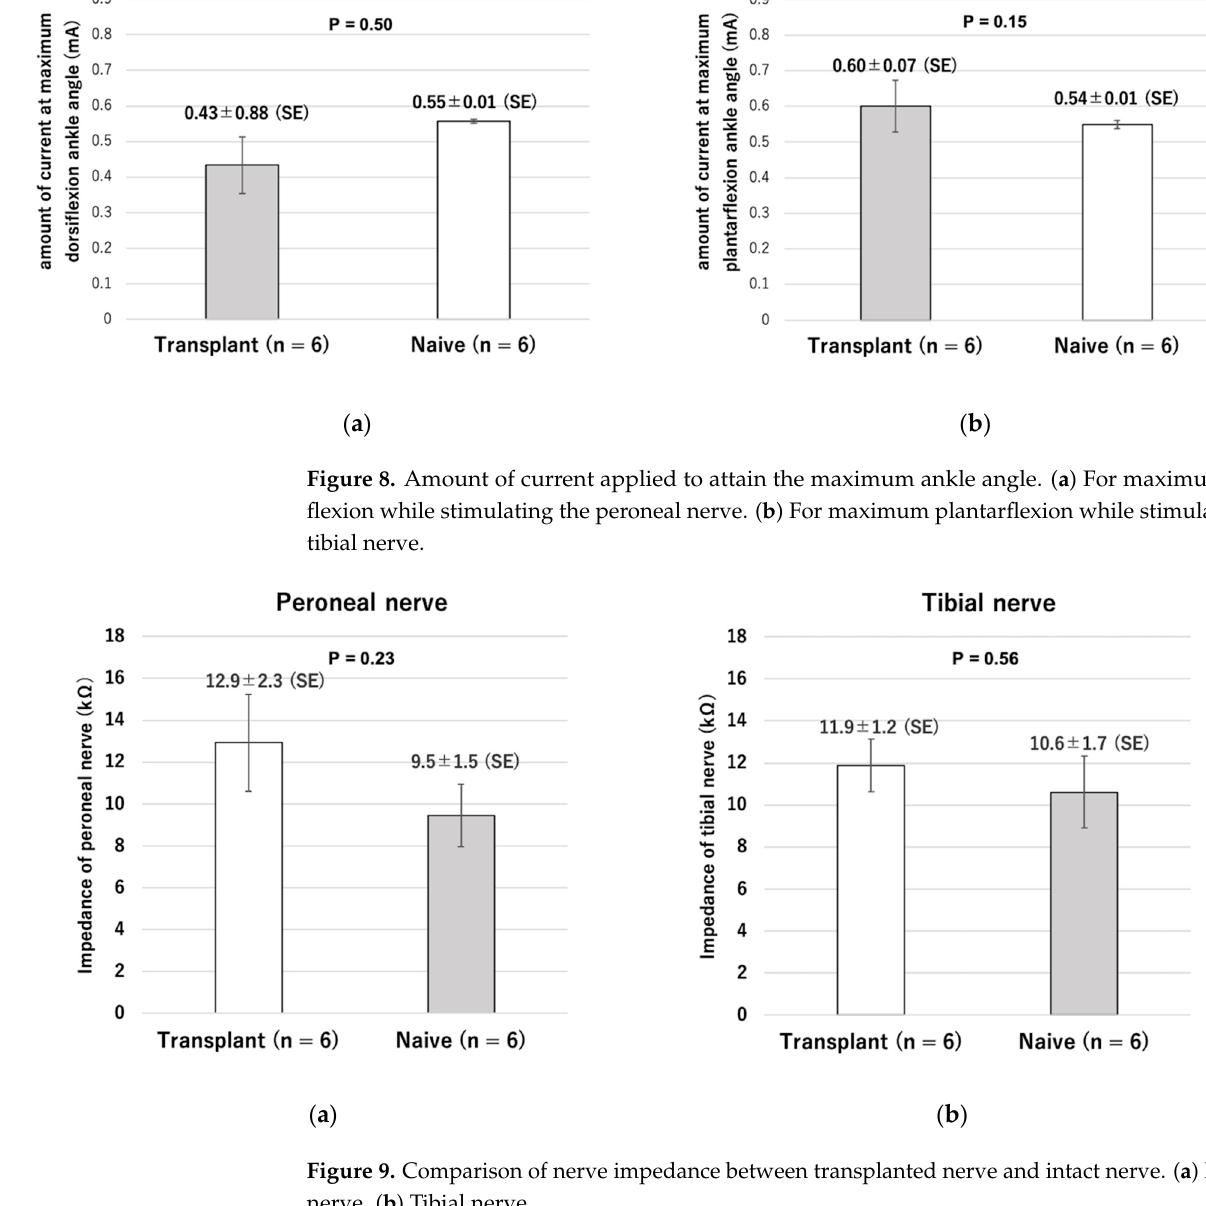
Figure 9. Comparison of nerve impedance between transplanted nerve and intact nerve. ( a ) Peroneal nerve. ( b ) Tibial nerve.